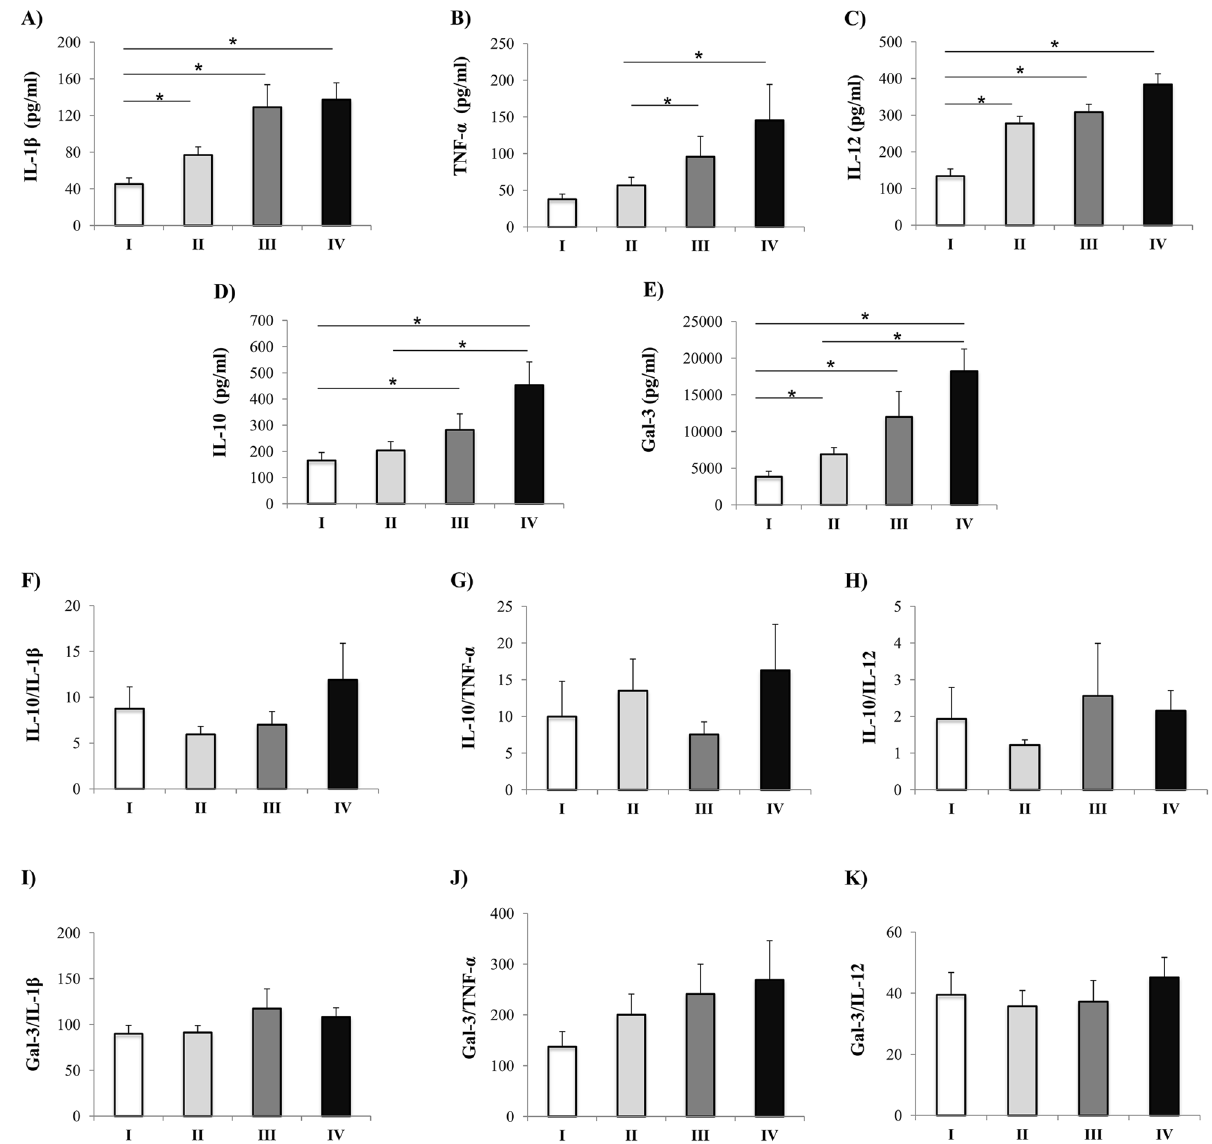
Figure 1. Systemic values and ratios of innate immunity cytokines. According to the disease severity, all Coronavirus disease 2019 (COVID-19) patients were divided in four groups (stage I (n = 61), II (n = 69), III (n = 54), IV (n = 48)). Systemic values of tumor necrosis factor α (TNF-α), interleukin (IL) 1β, IL-12, IL-10, and Galectin-3 were determined by ELISA. The ratios of IL-10/IL-1β, IL-10/TNF-α, IL-10/IL-12 as well as Gal-3/ IL-1β, Gal-3/TNF-α and Gal-3/IL-12 were evaluated for each patient, separately. For statistical significance determination, Kruskal–Wallis test, with post hoc Mann–Whitney Rank Sum test, was used. *p <